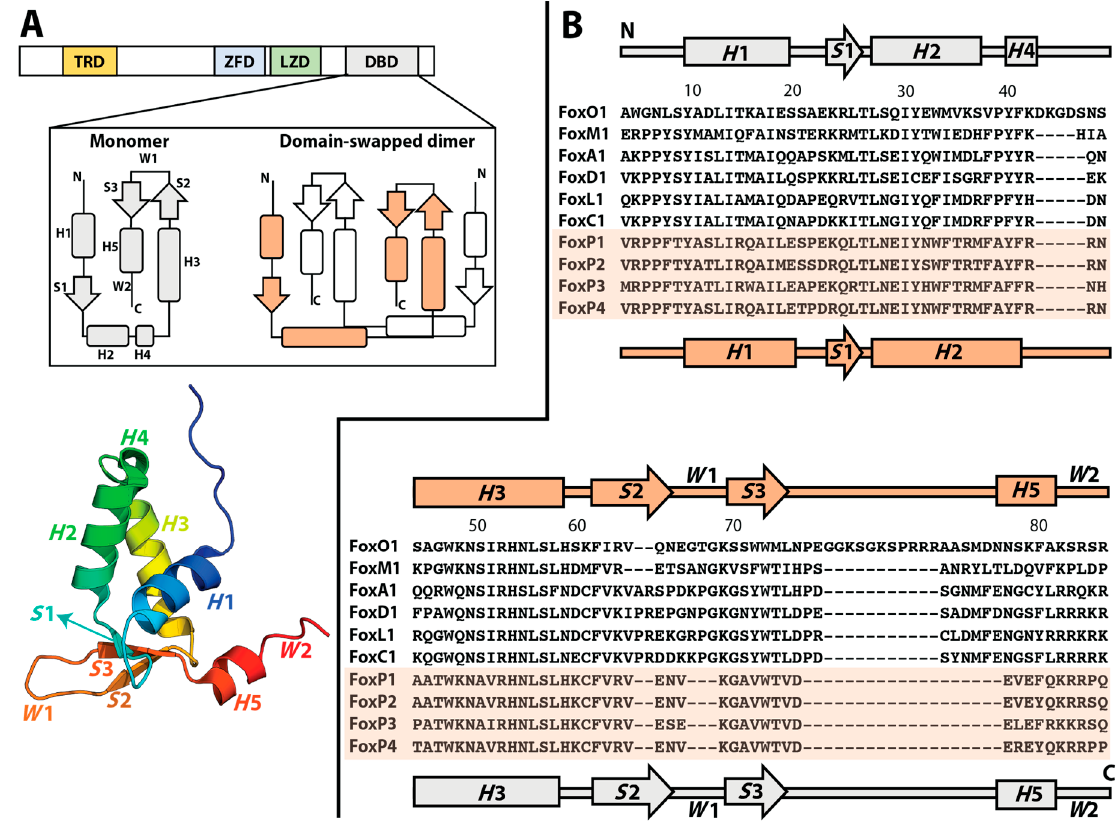
Figure 1. Three-dimensional domain swapping (3D-DS) in FoxP proteins. (A) Human FoxP proteins are constituted by a trans repressor domain (TRD), a zinc finger domain (ZFD), a leucine zipper domain (LZD), and a DNA-binding domain (DBD). Evolutionary changes in the latter enable FoxP proteins to associate into domain-swapped dimers. The secondary structure topology of the DBD is shown for both monomeric and dimeric FoxP. All secondary structure elements are colored and highlighted in the three-dimensional structure of a monomeric mutant of the DBD of FoxP1 (PDB 2KIU). (B) Sequence comparison of the DBD from different Fox subfamilies, showing the secondary structure topology for the monomeric members in gray and for the dimeric FoxP proteins in orange. Note that helices H2 and H4 in the monomer merge into a single helix H2 in the domain-swapped dimer. FoxP sequences are highlighted in light orange.